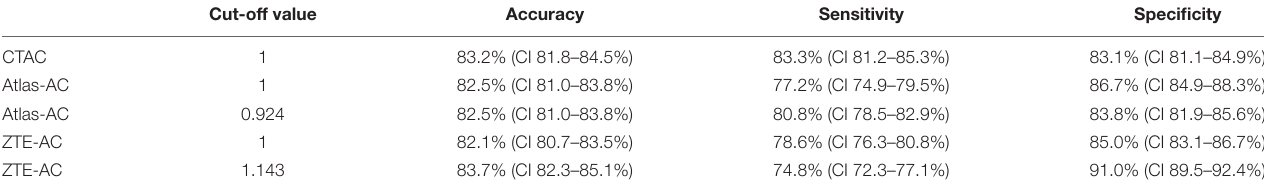
TABLE 2 | Diagnostic accuracy of original PET data and simulated MRAC PET data with various PET score values in each of the 2889 simulated